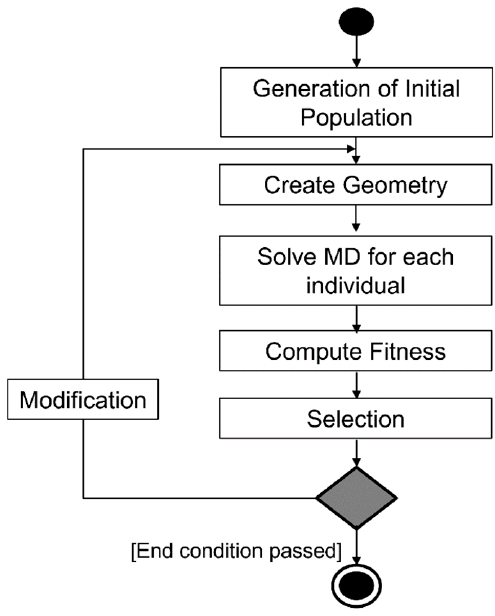
Figure 4. Evolutionary algorithm flowchart.